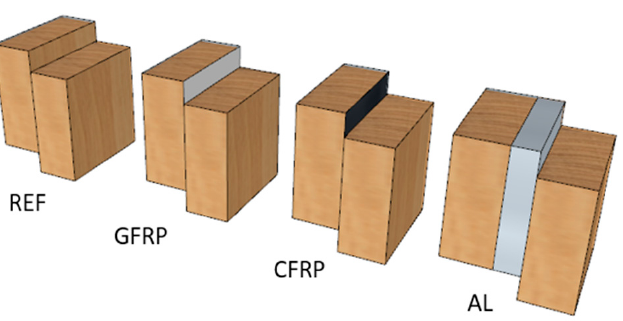
Figure 2. The Configurations of specimens (reference samples wood–wood, GFRP: glass fibre implant, CFRP: carbon fibre implant, AL: aluminium implant).